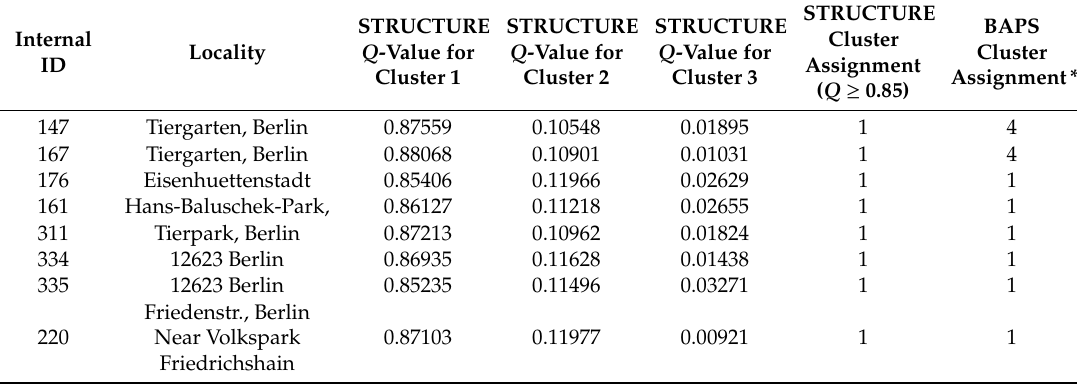
Animal ID, sampling location, Q -values (STRUCTURE) and cluster assignment for 143 hedgehogs of